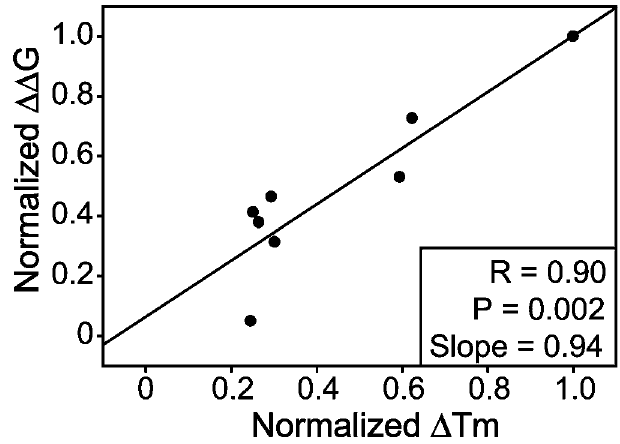
Figure 5. Correlation between Measures of Stability, Specifically Normalized D T m and DD G , Reported from Different Groups for Apo SOD1 Variants The variants with both measured D T m and DD G were plotted, and a good correlation between normalized D T m and normalized DD G was observed. This correlation provides the rationale for averaging D T m and DD G and taking the average value as an indicator for stability of fALS- related variants. The normalized D T m and DD G were obtained as described in the Materials and Methods